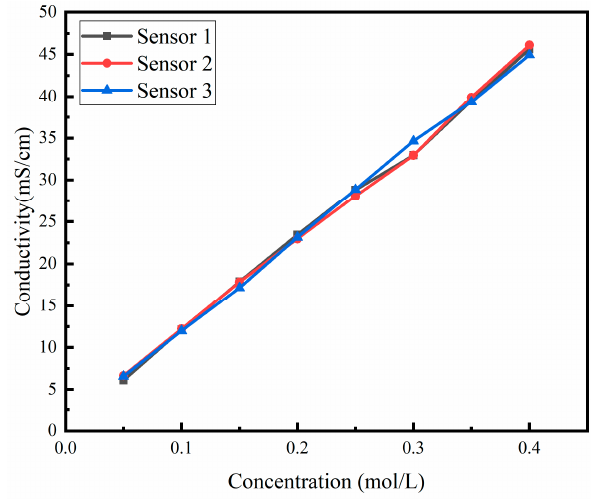
( b ) Figure 11. ( a )The measurement range of our sensor. The maximum range of our sensor can reach 107.41 mS/cm. ( b ) The precision of our sensor, and the measurement precision in low and medium range is about ±0.1 mS/cm. 5.2. Performance Consistency Conductivity tests were carried out on potassium chloride solutions with different concentrations using three distinct silicon-based thin-film conductivity sensors. As shown